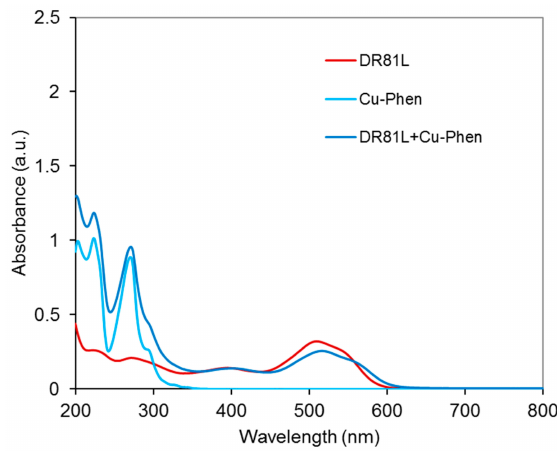
Figure 17. Absorbance spectrum of the dye/copper-phenanthroline system at pH 6.5, with Cu:Phen molar ratio = 1:2 and DR81:Cu molar ratio = 1:1.5, compared to the dye alone and copper-phenanthroline